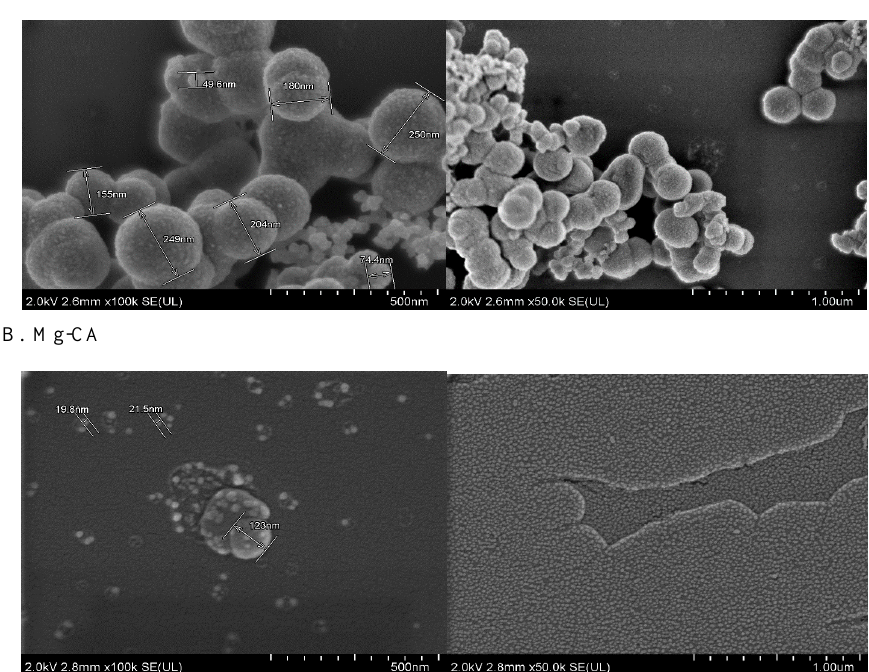
Figure 8. FESEM micrographs showing individual effects of Fe 3+ and Mg 2+ on CA NPs. Scale bar: 500 nm, and 1 µm. (A) Fe-CA (B) Mg-CA. After the respective particles were incubated and supplemented with 10% FBS, they were centrifuged twice for 15 min at 13,000 rpm. The supernatants were discarded and the pellets were resuspended in 20 µL Milli Q water. Then 3 µL of the respective NP suspensions was dried at room temperature for 45 min.